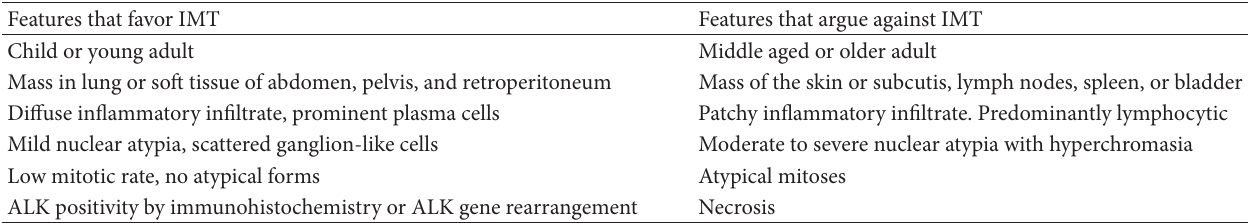
Table 1: Clinical and pathological features helping differential diagnosis of inflammatory myofibroblasic